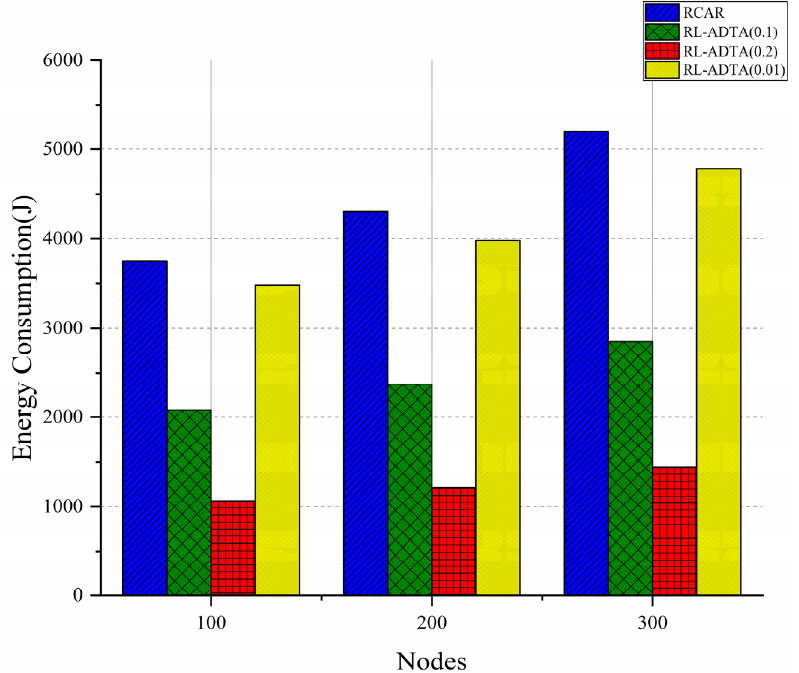
Figure 14. Comparison of energy consumption between RCAR and RL-ADTA (0.1, 0.2, 0.01). The comprehensive energy consumption of RCAR and RL-ADTA includes transmission, reception, calculation, and idle energy consumption.